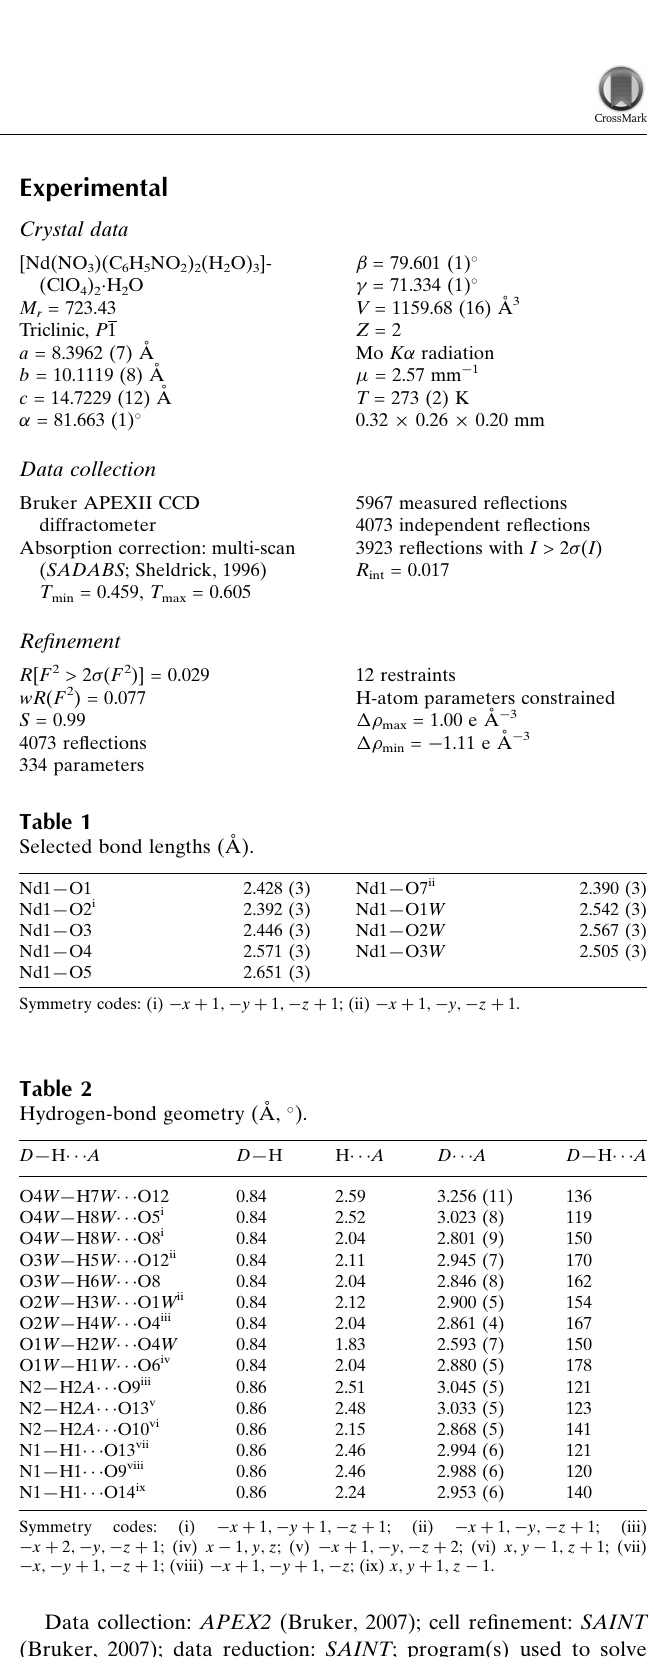
SHELXTL (Sheldrick, 2008); software used to prepare material for publication: SHELXTL